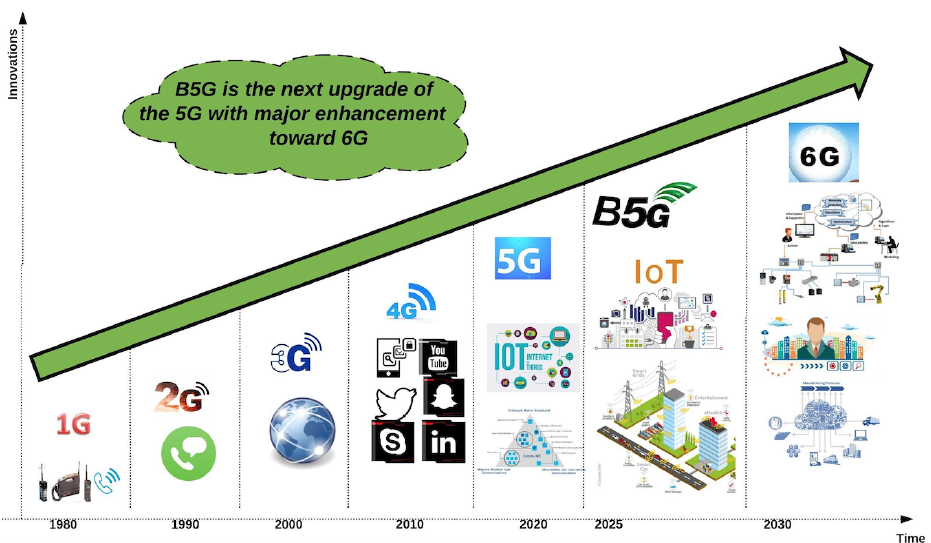
Figure 1. Evolution of cellular network